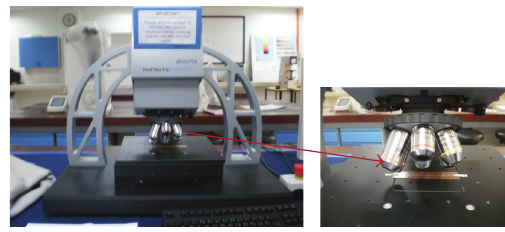
Figure 3: Infinite Focus